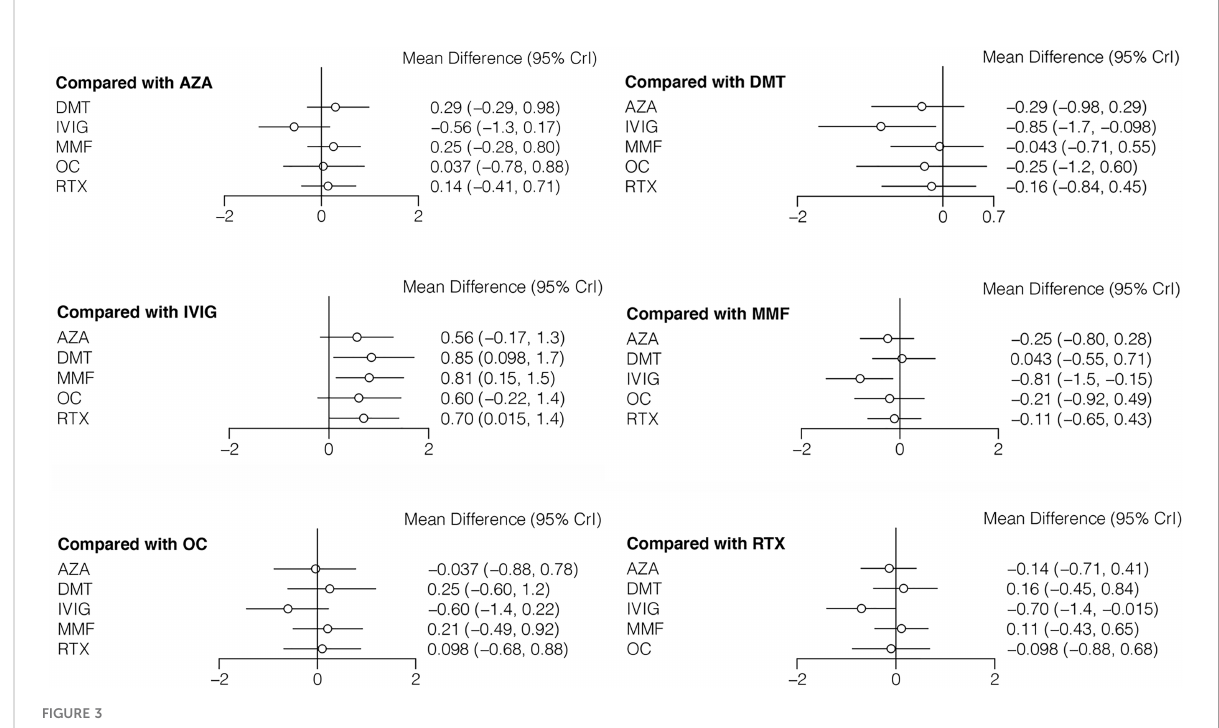
FIGURE 3 Forest plots of network meta-analysis for annualized relapse